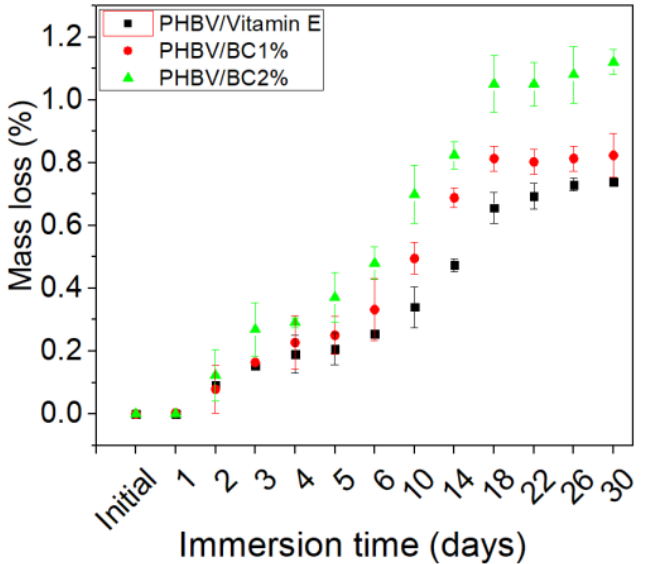
Figure 2. Mass loss of PHBV/BC biocomposites immersed in PBS as a function of exposure time (after 30 days in vitro hydrolytic degradation).